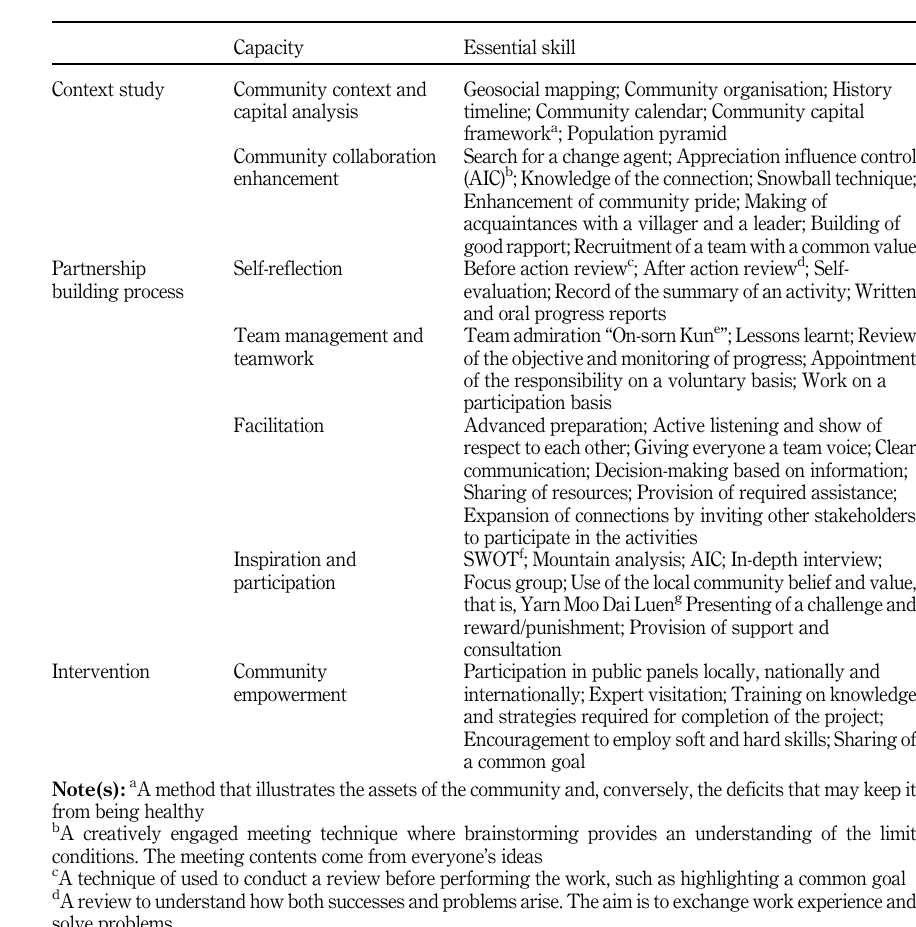
Table 2. Role of PLC in UBRU ( N 5 54)